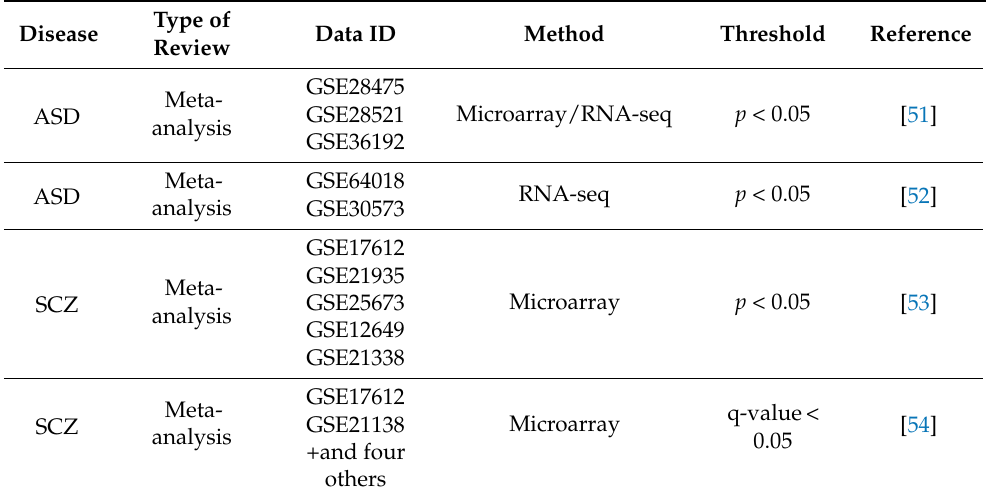
Table 2. Publicly available meta-analyses of postmortem cortical transcriptomes of SCZ and ASD patients. Type Disease